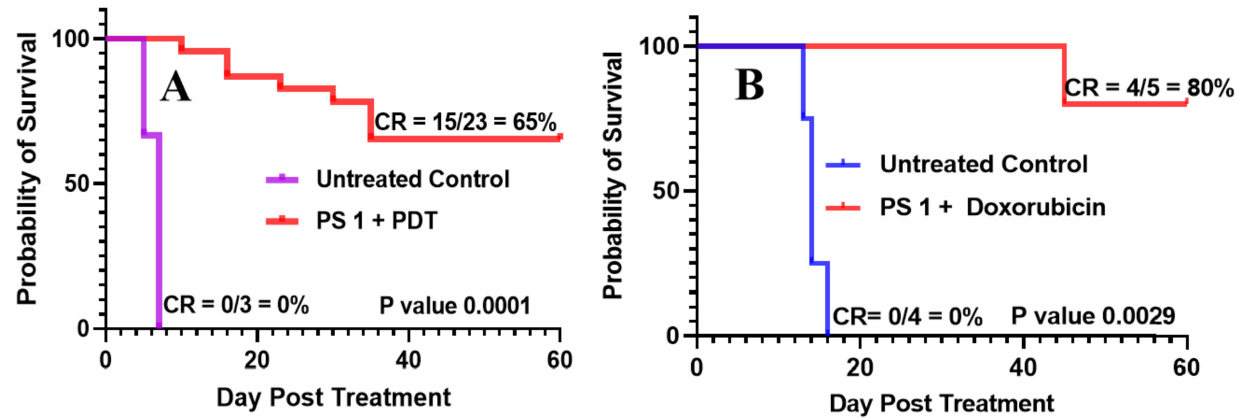
Figure 10. ( A ) SCID mice were injected intravenously with PS 1 at a dose of 1.0 µ mol/kg; the tumors were irradiated with light (665 nm, light dose: 135 J/cm 2 , 75 mW/cm 2 ) at 24 h post-injection. ( B ) In a second set of experiments , five SCID mice bearing SCLC 14541 tumors after PDT treatment as discussed above were injected (i.v.) with doxorubicin (2.5 mg/kg × 1 dose), and tumor regrowth of mice in both sets of experiments was monitored daily for 60 days. If there is any tumor regrowth, the mice were euthanized on that day. On day 60, mice with no tumor regrowth (cure) were also euthanized following an approved protocol